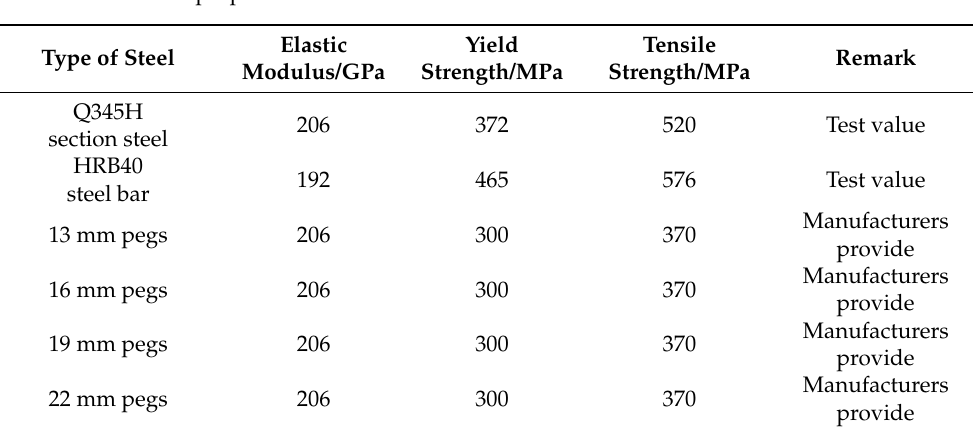
Table 4. Mechanical properties of steel materials.